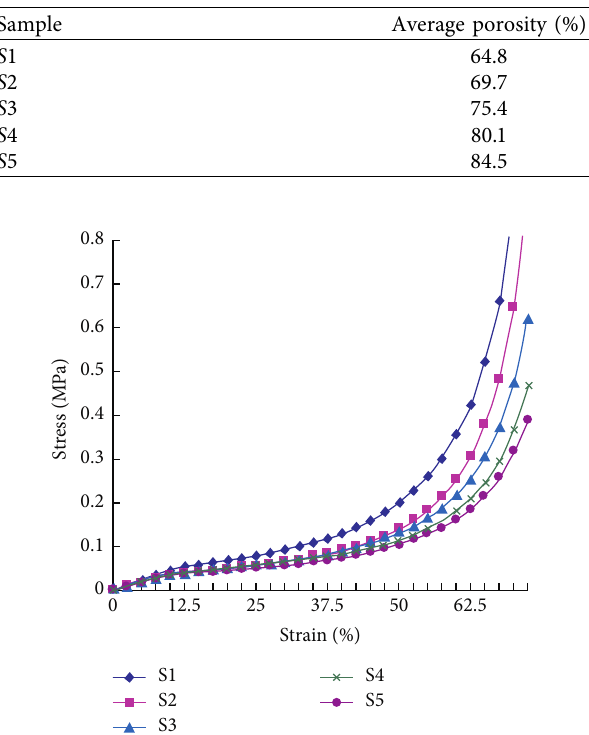
Figure 4: Stress-strain curves of cushion materials of different